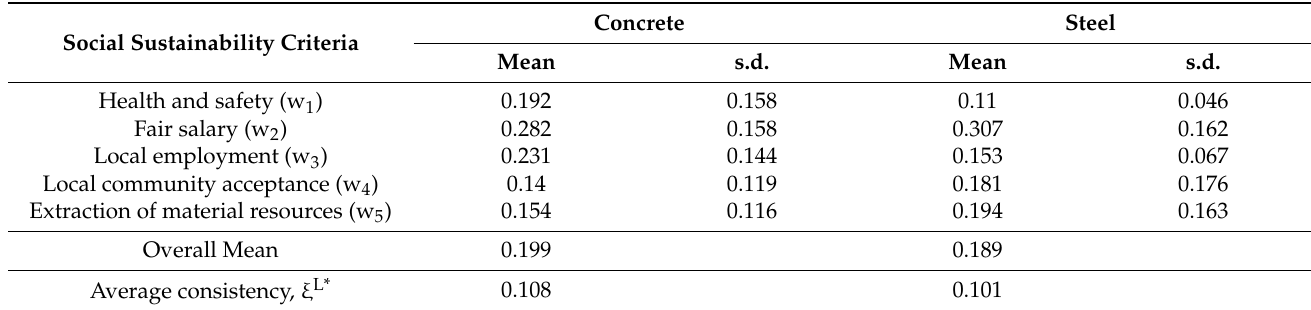
Table 6. Optimal weights for five social indicators.